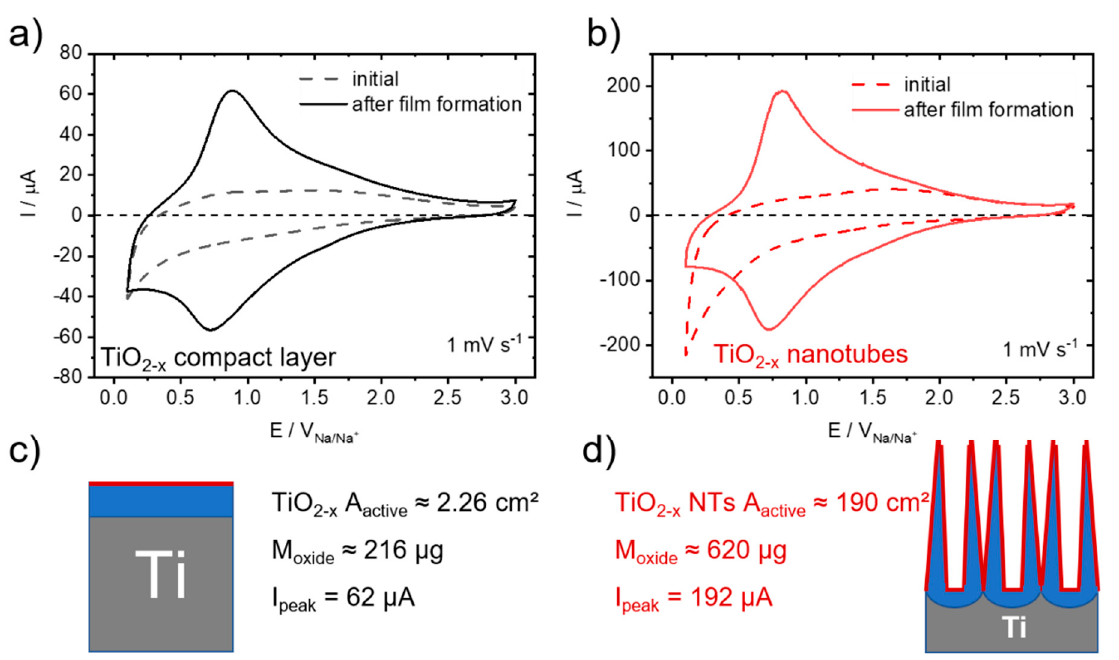
Figure 4. Electrochemical characterization and comparison. CV measurements for the initial (dashed line) and aged (solid line, after film formation) electrodes with ( a ) a compact TiO 2 − x layer and ( b ) self-organized TiO 2 − x NTs. Scheme and key parameters measured for ( c ) a compact TiO 2 − x layer and ( d ) self-organized TiO 2 − x NTs.